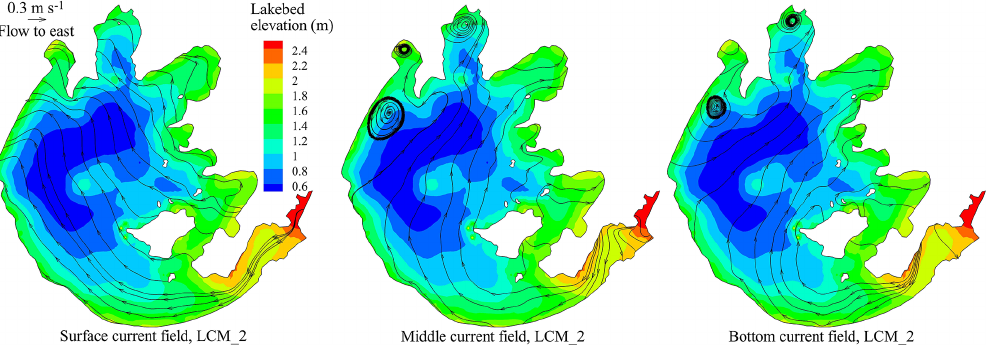
Figure B5. Comparison of the LCM_2-simulated stream traces of the surface, middle, and bottom current fields in Lake Taihu at 12:00LT on 10 August